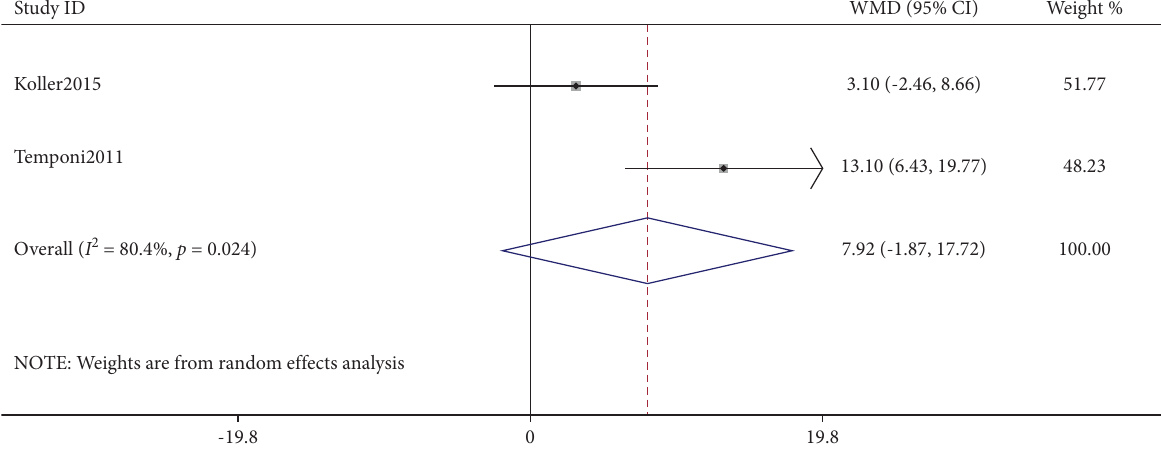
Figure 4: Comparison of kyphosis correction between the combined anterior-posterior approach and the posterior-only